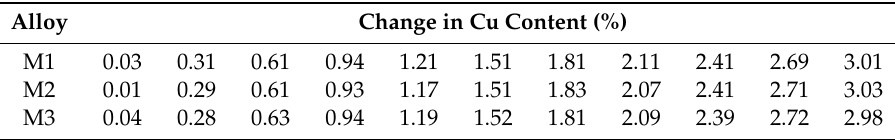
Table 2. Change in Cu in alloy composition in wt%.